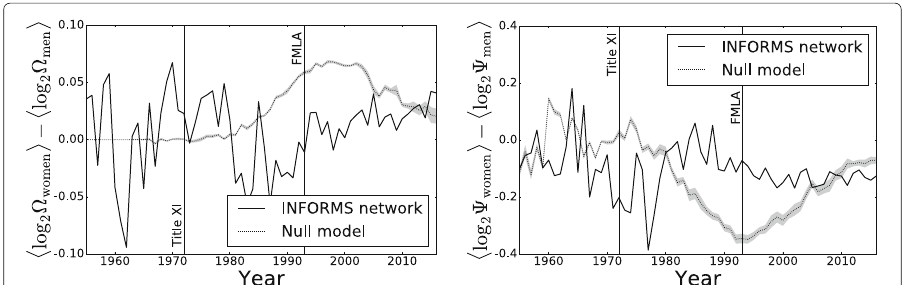
Fig. 8 Differences in measures of authorship importance of women and men have recently tapered off. Gender differences (women minus men) over time in average edge importance measures (effective resistance, log 2 (cid:4) , left; and contraction importance, log 2 (cid:5) , right). The solid curve is the difference in the INFORMS dataset, and the dotted curve in the null model, which replicates the yearly degree distributions